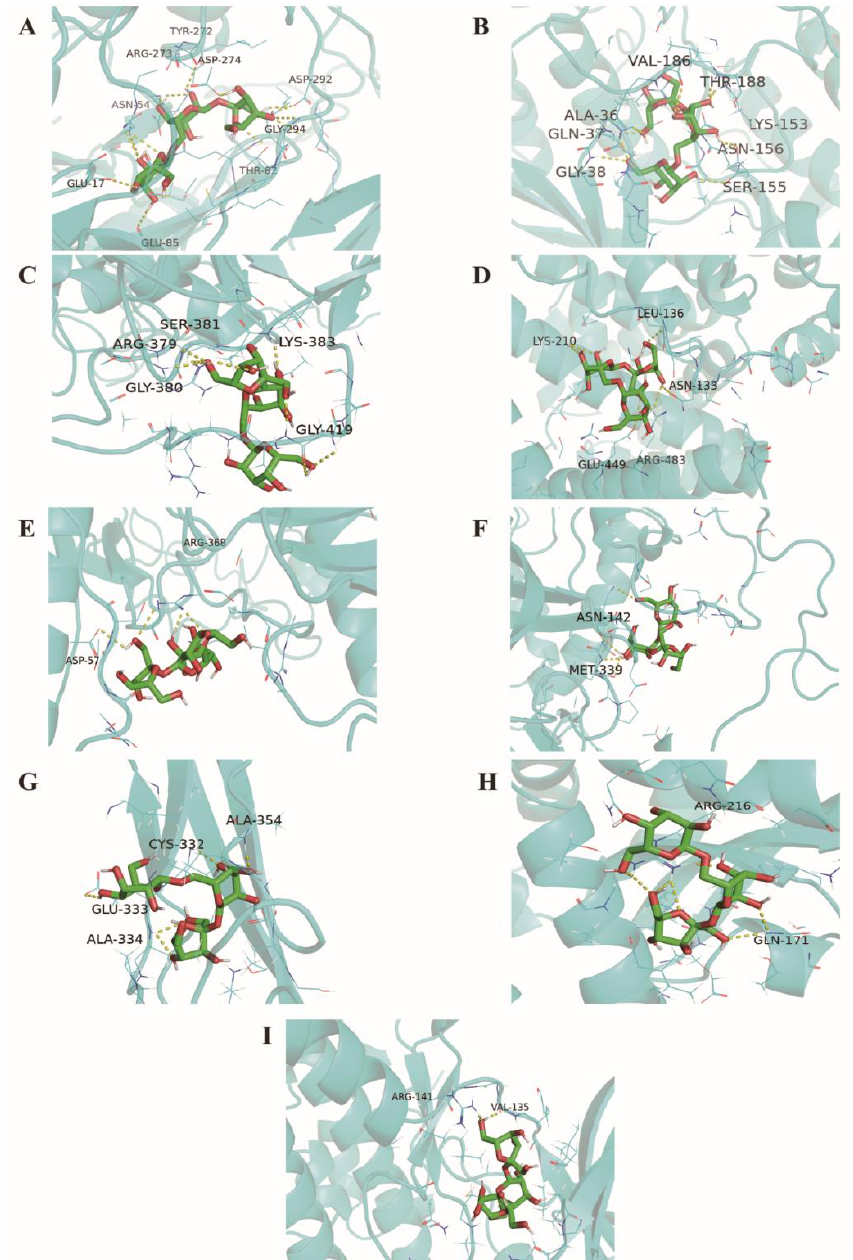
Figure 8. Binding pattern of ROS to Akt1 ( A ), Mapk8 ( B ), Stat3 ( C ), Alb ( D ), Hsp90aa1 ( E ), Cat ( F ), Icam1 ( G ), Sod2 ( H ), and Gsk3b ( I ).